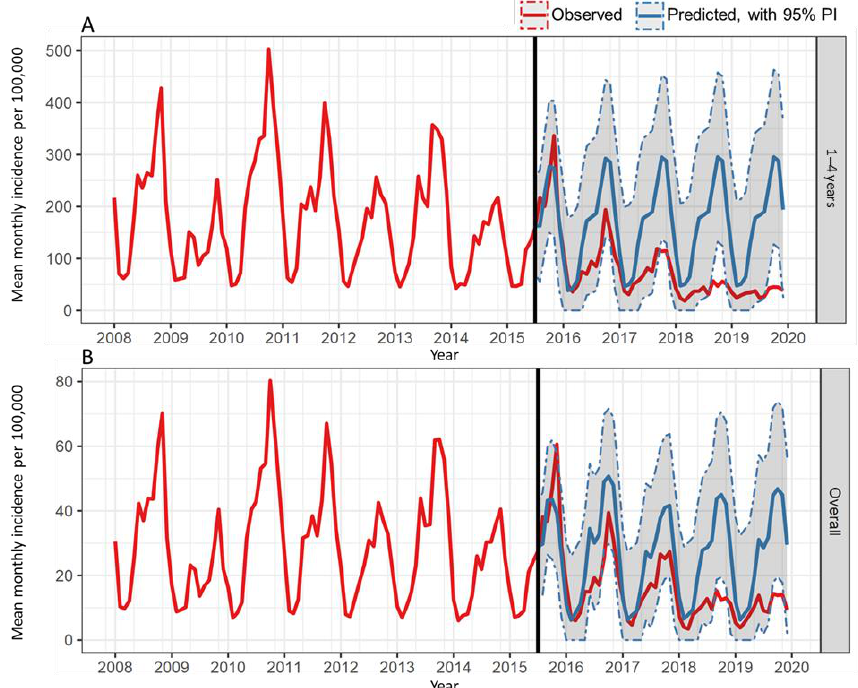
Figure 2. Trends in observed and predicted mean incidences of varicella in the target population ( A ) and overall population ( B ) in the pre- and post-UVV periods, derived from monthly data. The solid line corresponds approximately to the period of UVV introduction in Argentina. CI, confidence interval; observed, observed incidence following UVV introduction; predicted, predicted incidence without UVV introduction; UVV, universal varicella vaccination. In the target population, the observed incidence was significantly lower than the pre- dicted incidence (without UVV) in October and November in 2017 ( −6 1.4% and −6 0.1%), and in September, October, and November in both 2018 ( − 76.7%, − 84.1%, and −8 0.5%) and 2019 ( − 82.2%, − 84.7%, and −8 4.5%) (Table S3). In the analysis of peak and non-peak peri- ods, significant differences in observed versus predicted mean incidences were found in peak periods from 2017, reaching reductions of 83.9% (95% PI: 58.9, 90.0) in 2019 (Figure 3). Declines were also observed in non-peak periods from 2016.